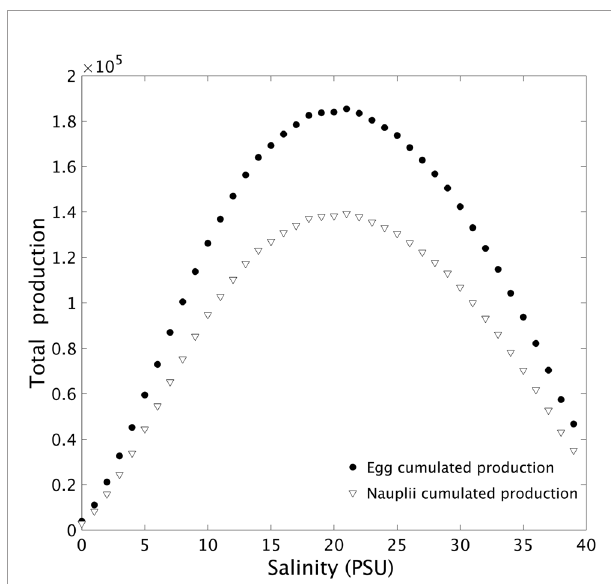
FIGURE 8 | Relation between the cumulated mean production of eggs and nauplii by 1000 females after 20 days and the salinity condition